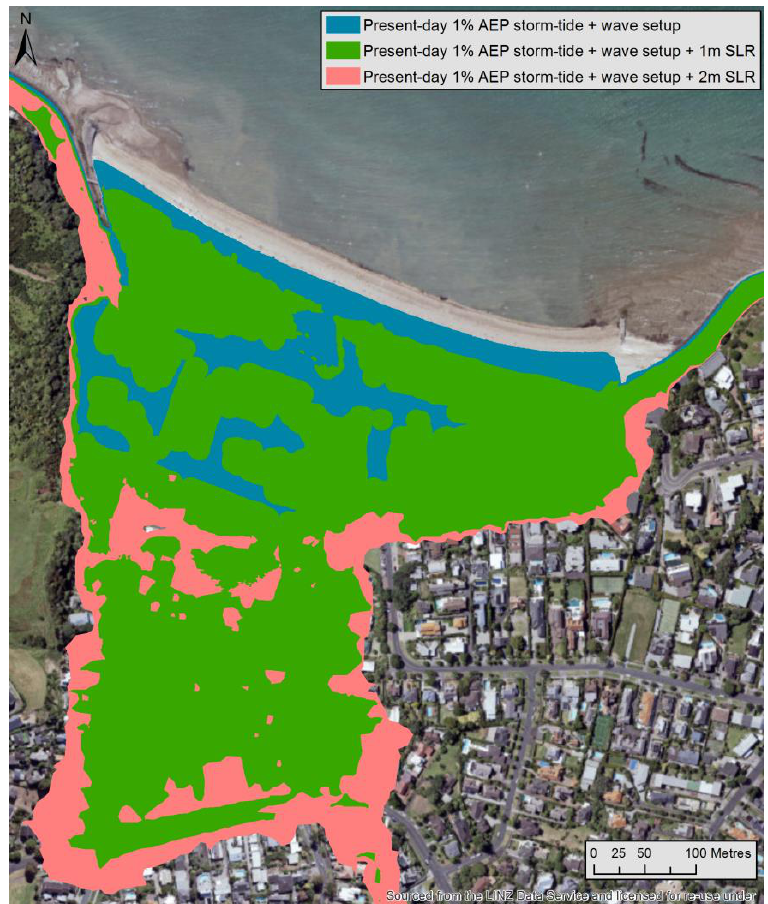
Figure 4. Coastal-storm flood mapping example at Mission Bay, Auckland. Aerial photograph of Mission Bay with present-day 1% AEP storm-tide plus wave setup elevation superimposed (blue shading), plus 1 m SLR (green shading), and plus 2 m SLR (pink shading). After: (50 @Engineers Australia, 2015).